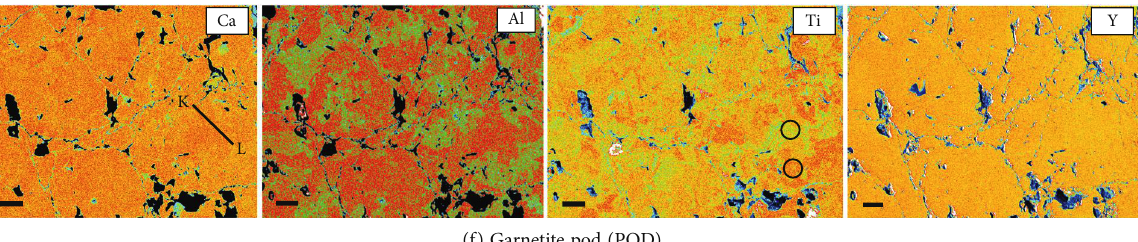
Figure 6: Representative examples of major and trace element (Y and Ti) zoning in garnet. (a) Garnet in a pegmatite (PgD) showing increasing Ca and decreasing Mn from core to rim along pro fi le A – B (Figure 5(b)). The garnet exhibits Ti enrichment in its core and sector zoning and a slight decrease in Y from core to rim. (b) The garnet in PgC exhibits similar zoning of Mn as that in PgD, but also sector zoning of Ca and trace elements, and oscillatory zoning of Ti. (c) The garnet in PgB exhibits similar Ca zoning and the opposite Mn zoning as that in PgD, moderate Ti zoning, and no zoning of Y. The holes in the middle of the garnet are laser ablation pits. (d) A single garnet grain in a Bt schist (BSa) that is mostly unzoned. (e) Garnet in a Qz schist (QS) that has a Ca-rich core as compared with its rim and has uniform Mn, Ti, and Y contents (i.e., it is unzoned). (f) Garnetite pod with irregular zoning of Al and Ti and uniform Ca and Y contents. The scale bar is 100 μ m long. Ap: apatite; Bt: biotite; Grt: garnet; Pl: plagioclase; Qz: quartz. The black or white open circles on the Ti maps are the sites of laser ablation